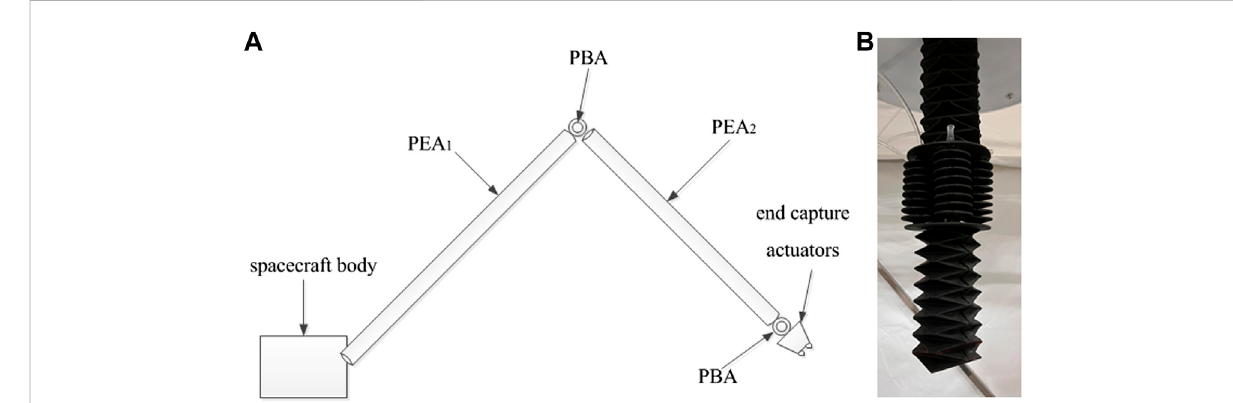
FIGURE 1 Soft space capture robot and soft robotic arm. (A) Soft capture robot. (B) Soft robotic arm.